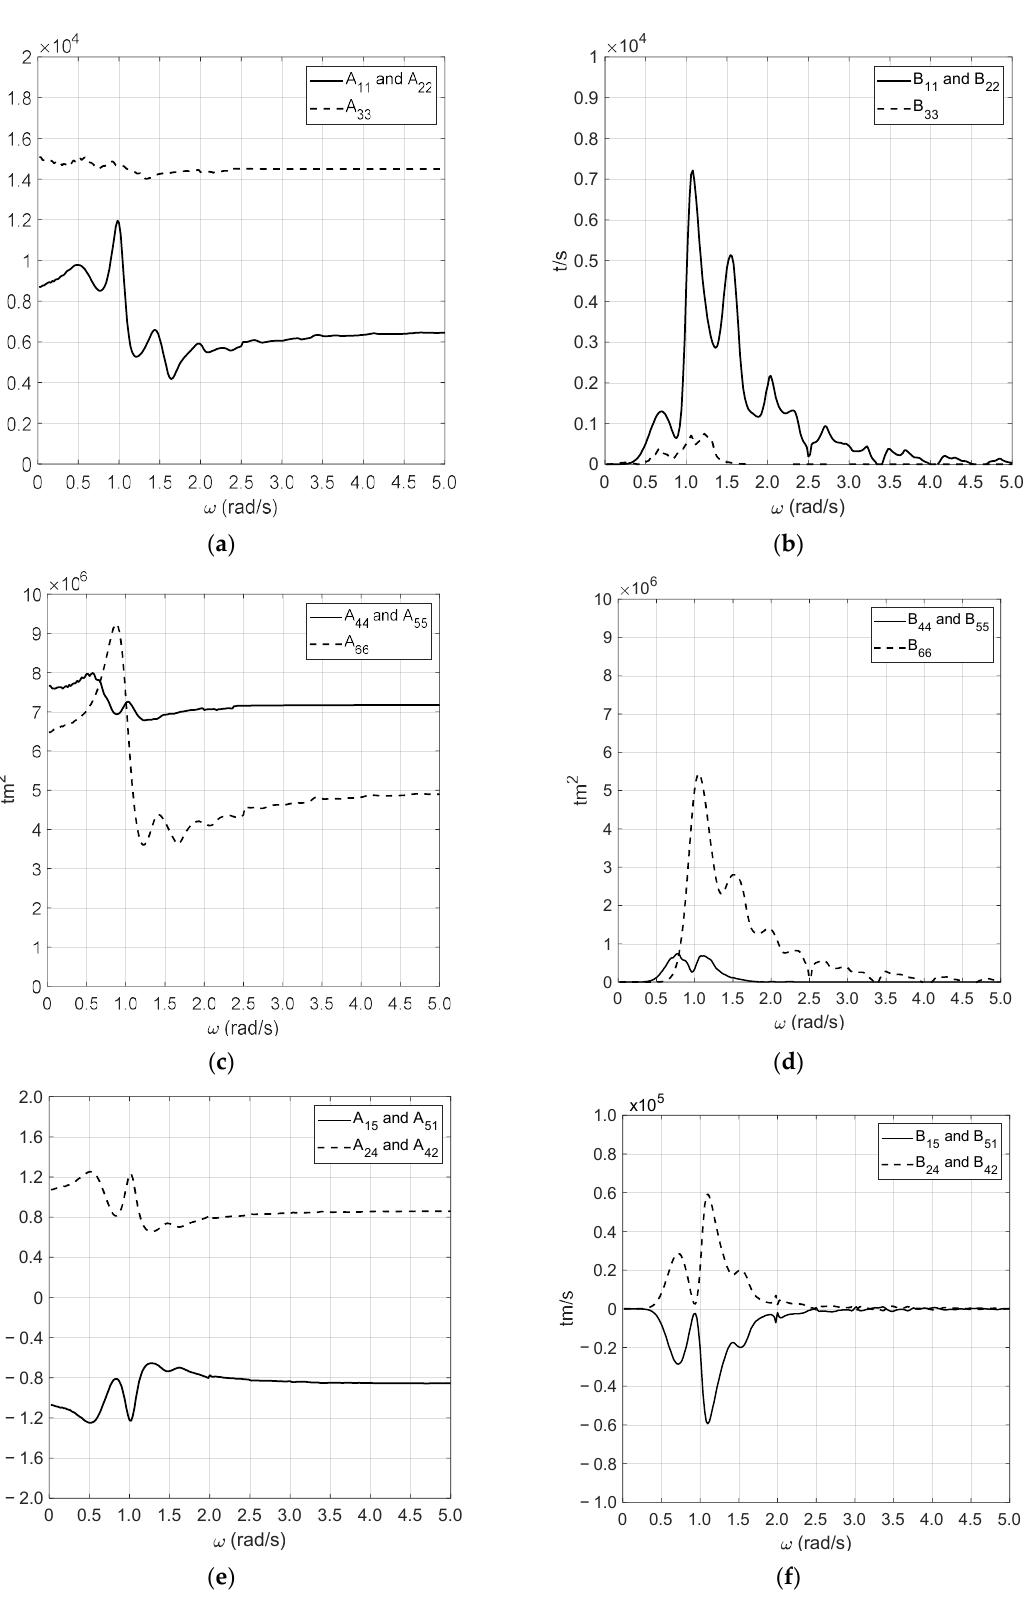
Figure A1. Absolute exciting forces per unit wave amplitude of the OC4-DeepCWind platform. ( a ) Surge/heave motion; ( b ) pitch motion.